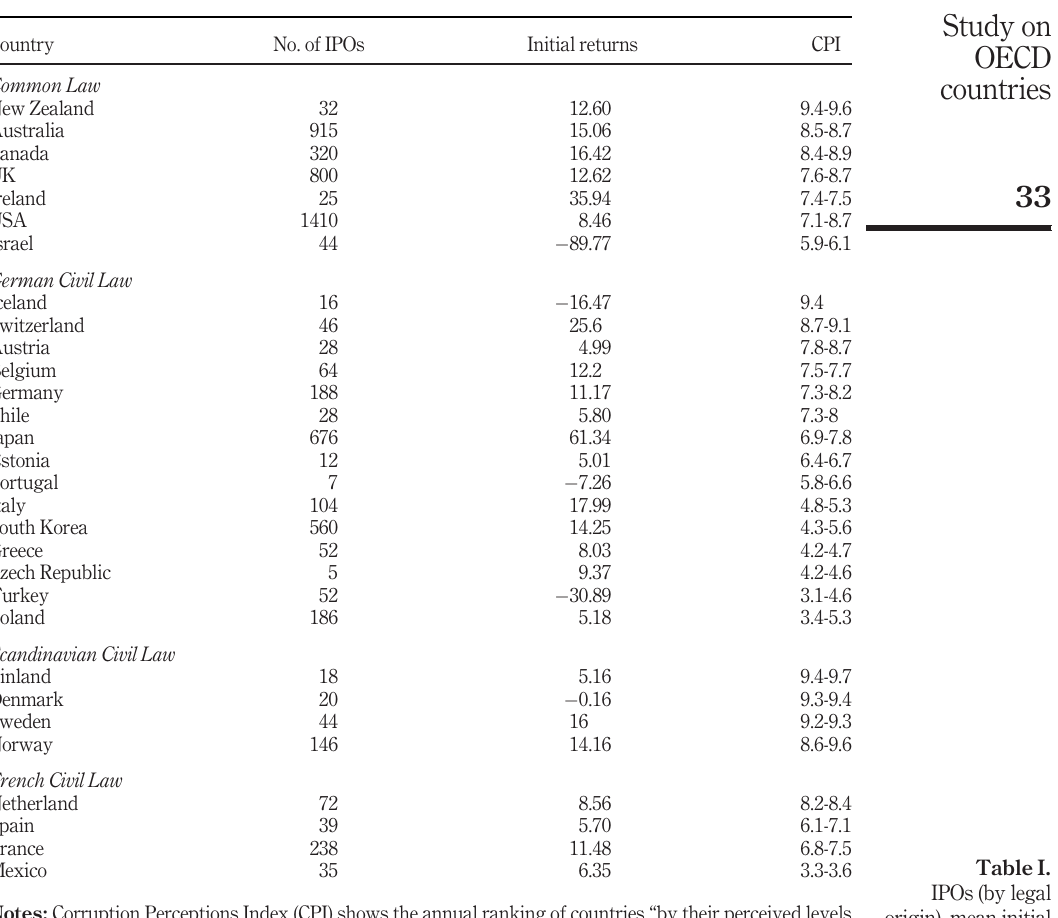
origin), mean initial returns and CPI of selected OECD countries for the period